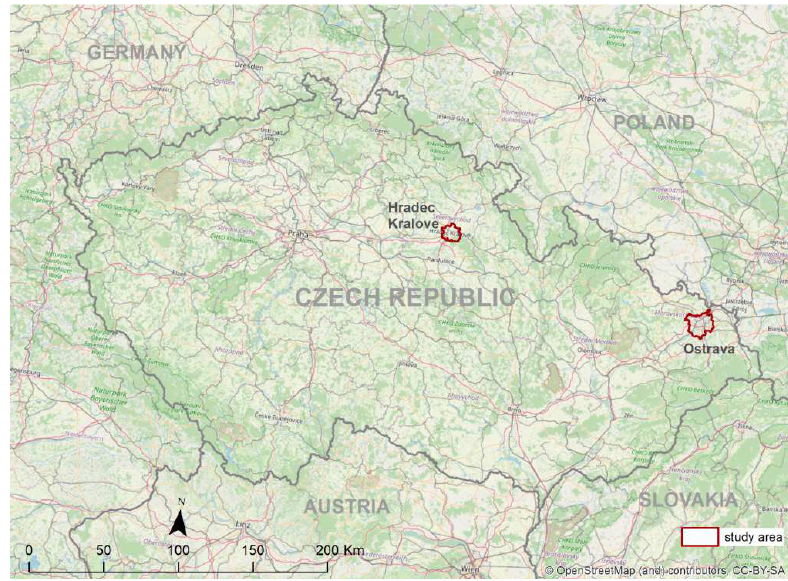
Figure 2. Location of evaluated cities.